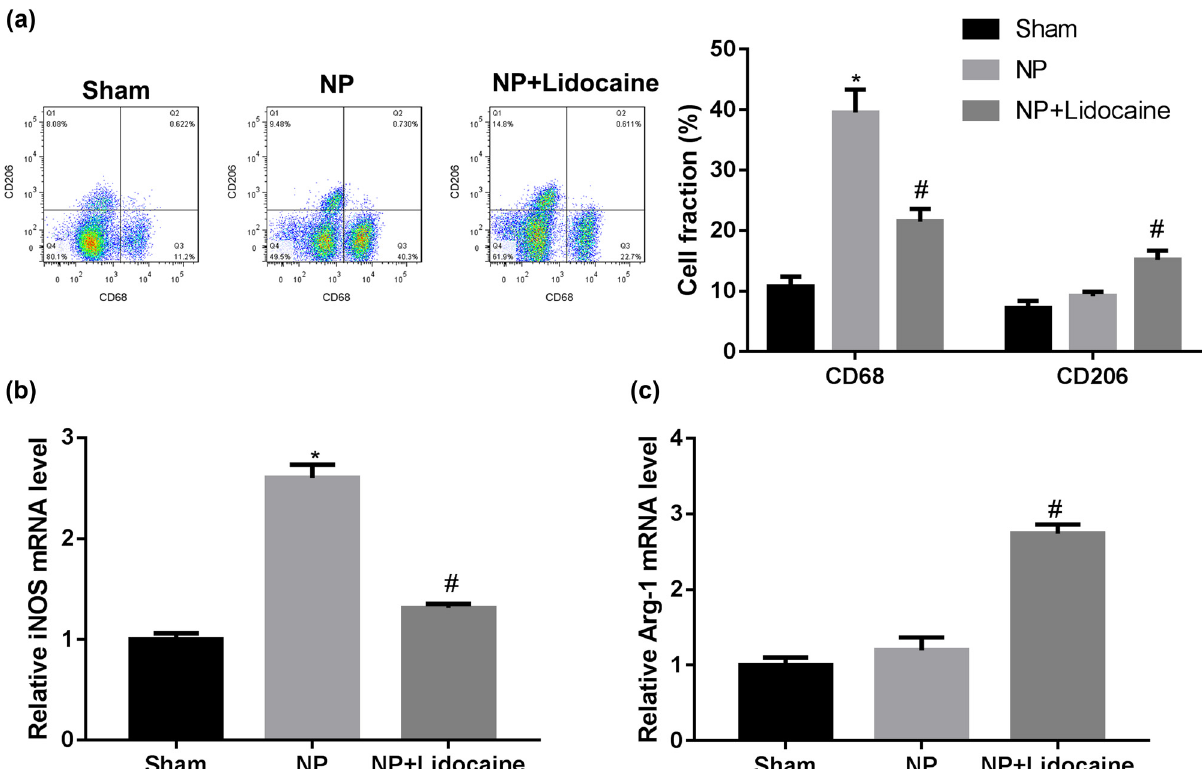
Figure 3: Lidocaine regulated M1/M2 microglia polarization in a rat model of CCI - induced NP. The rats in di ff erent groups were sacri fi ced at 14 days, and L4 – L6 segments of the rat spinal cord were separated and microglia were isolated. ( a ) Flow cytometry was used to detect the proportion of M1 and M2 microglia, as evidenced by the fraction of CD68 + cells and CD206 + cells. RT - PCR was used to detect the expression of M1 marker iNOS ( b ) and M2 marker Arg - 1 ( c ) . Data are expressed as mean ± SD and were analyzed using one - way ANOVA with Tukey ’ s post hoc test.* p < 0.05 versus Sham group; # p < 0.05 versus NP